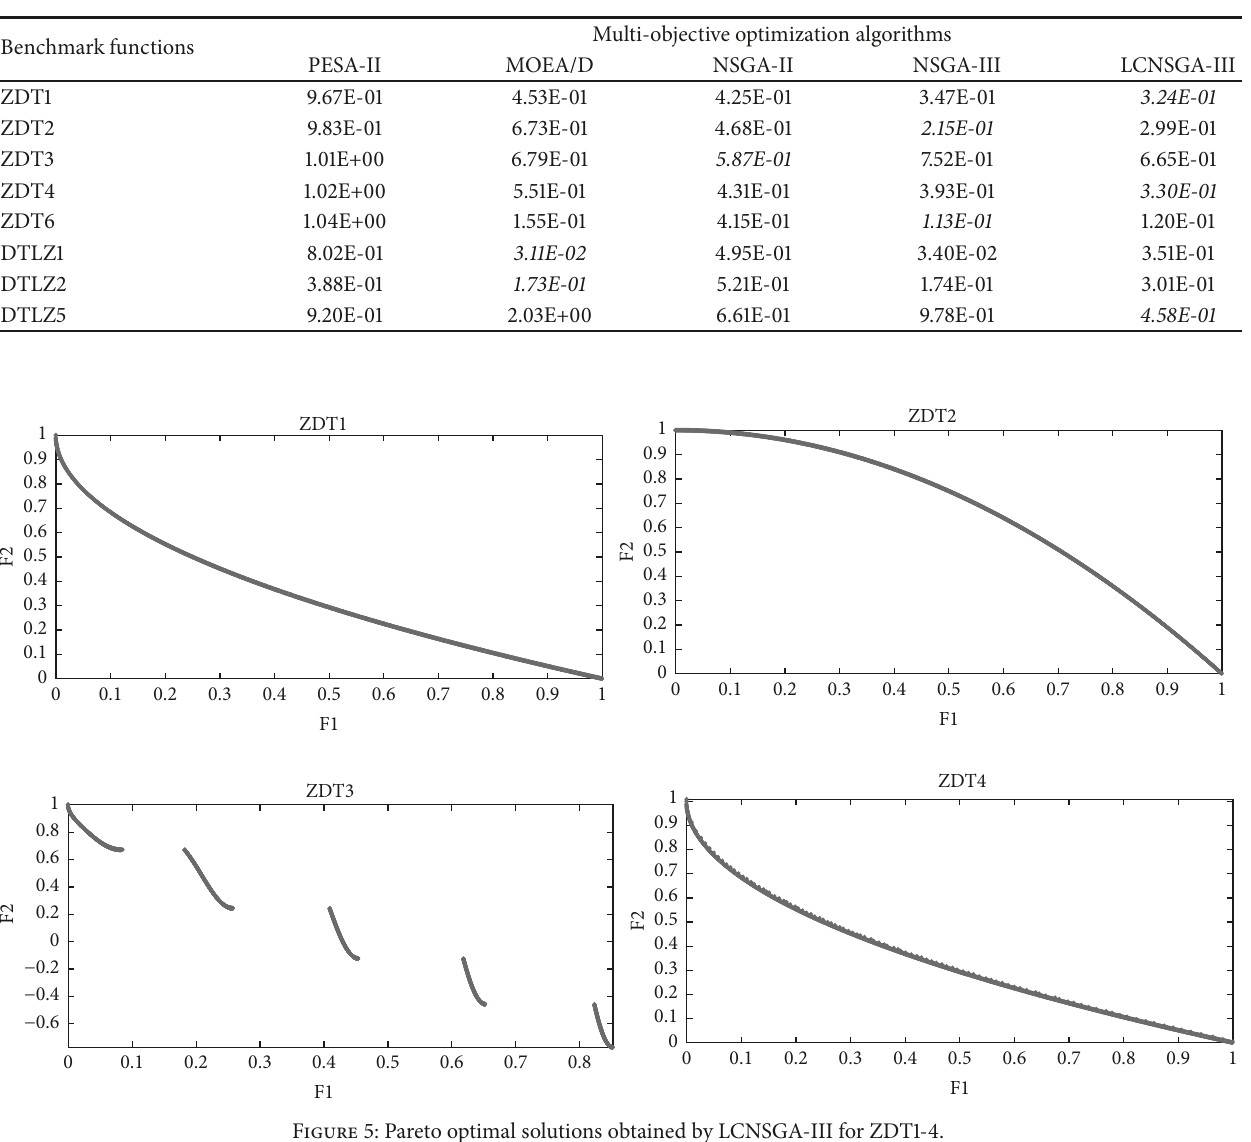
Table 3: Comparison of Spread for eight benchmark functions.